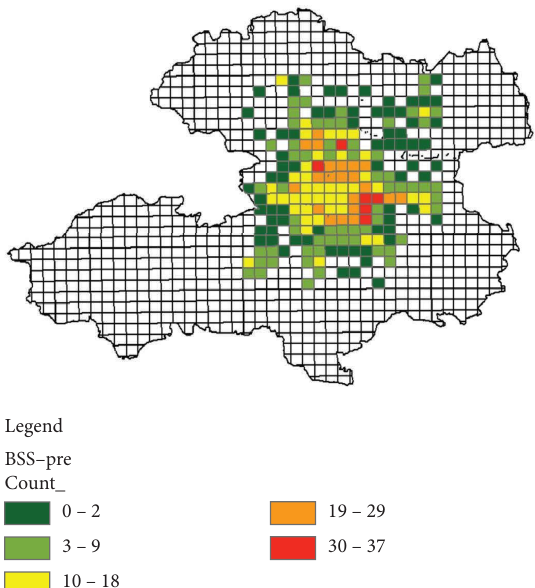
Figure 23: Te predicted number of battery swap